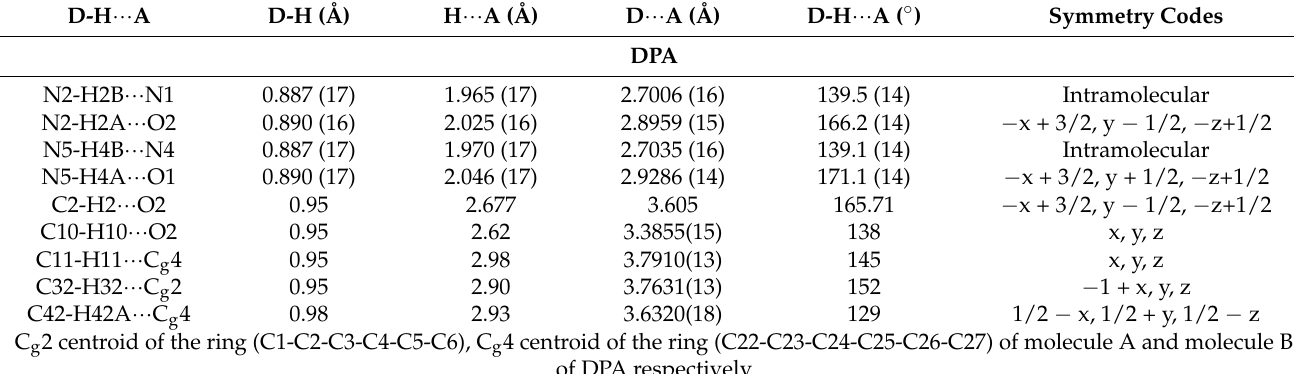
Table 2. Geometrical parameters of the hydrogen bond interaction in DPA and DPA_PA